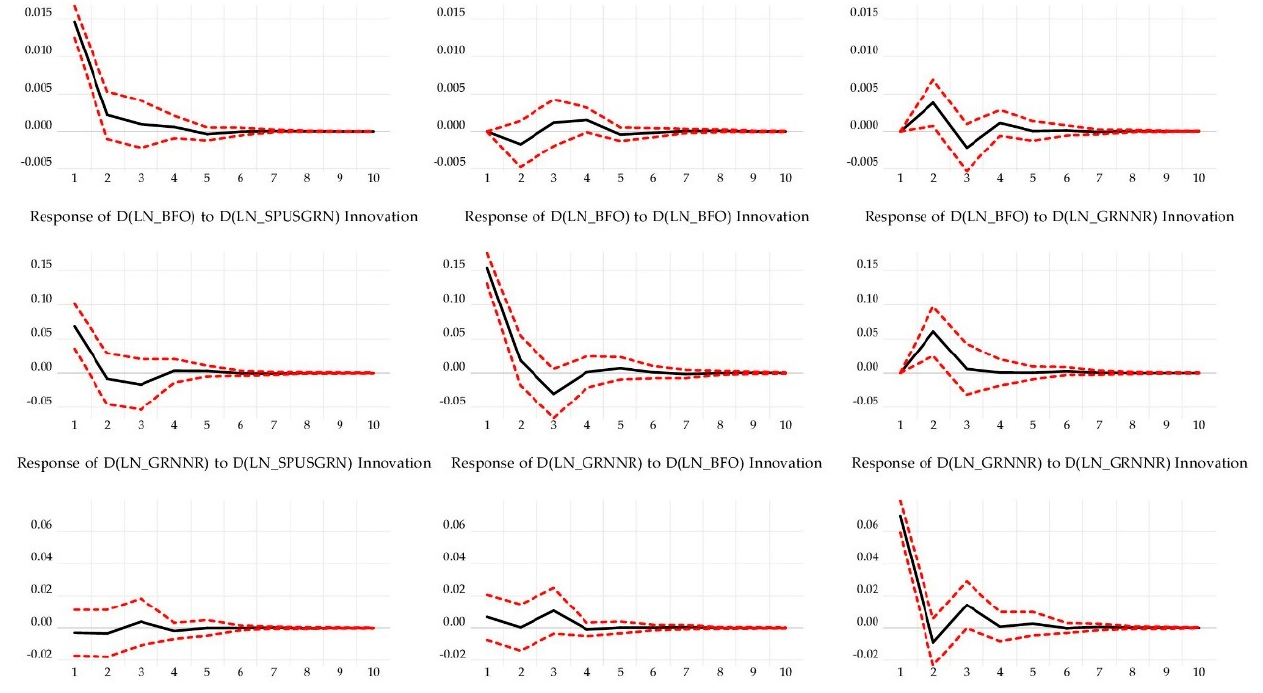
Figure A2. Response to Cholesky one std. dev. Innovations ±2 analytic asymptotic std. errors in model 2.